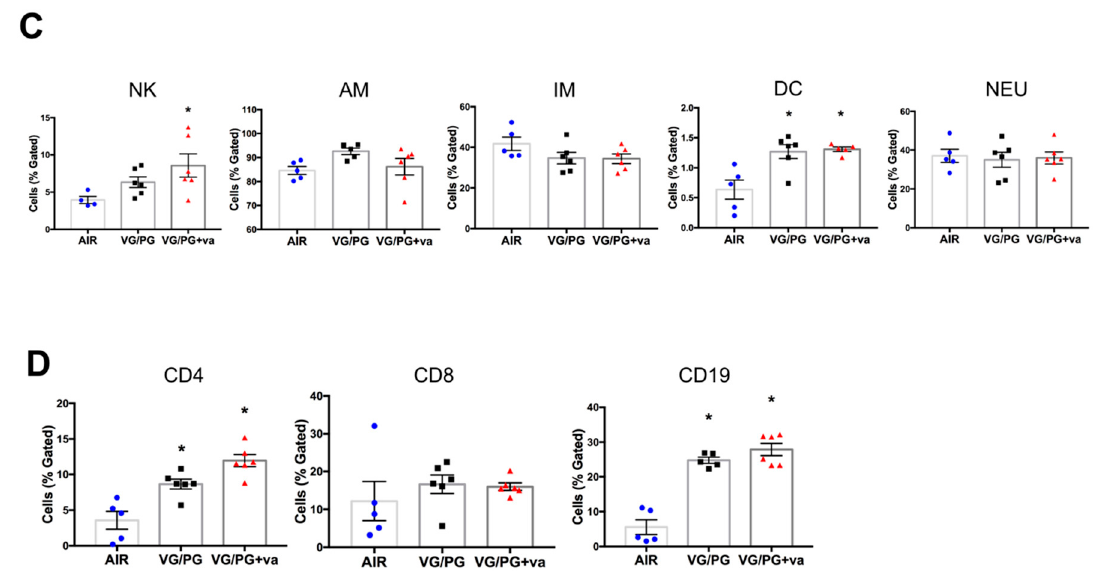
Figure 3. Inhalation of e-cig aerosols composed of 70% / 30% VG / PG alone or with vanilla flavor increases lung immune cells. ( A , B ) Gating Strategy for Identifying Lung Innate and Adaptive Immune Cells. ( A ) NK cells were identified as CD49 +/ CDllb − , AMs as F4 / 80 +/ CD11c +/ CD11b − , IMs as F4 / 80 +/ CD11b +/ Gr1 − , DCs as CD11b +/ CD11c + , and Neutrophils as CD11b +/ CD11c − / Gr1 + . ( B ) T helper cells were identified as CD4 + , cytotoxic T cells as CD8 + , and B cells as CD19 + . Extracellular staining for innate ( C ) and adaptive ( D ) immune cells in the lungs of mice treated with air ( n = 5), VG / PG ( n = 6), or VG / PG ( n = 6) with vanilla. * p < 0.05. Cells were identified as natural killer cells (NK, CD49 + , CDllb − ), alveolar macrophages (AM, F4 / 80 + , CD11c + , CDllb − ), interstitial macrophages (IM, F4 / 80 + , CDllb + , Gr1 − ), dendritic cells (DC, CDllb + , CDllc + ), neutrophils (NEU, CD11b + , CDllc − , Gr1 + ), cytotoxic T cells (CD8 + ), T helper cells (CD4 + ), or B cells (CD19 + ). Error bars are SEM. Differences were analyzed by one-way ANOVA, and a Grubb’s outlier test was utilized to identify outliers in each treatment group.